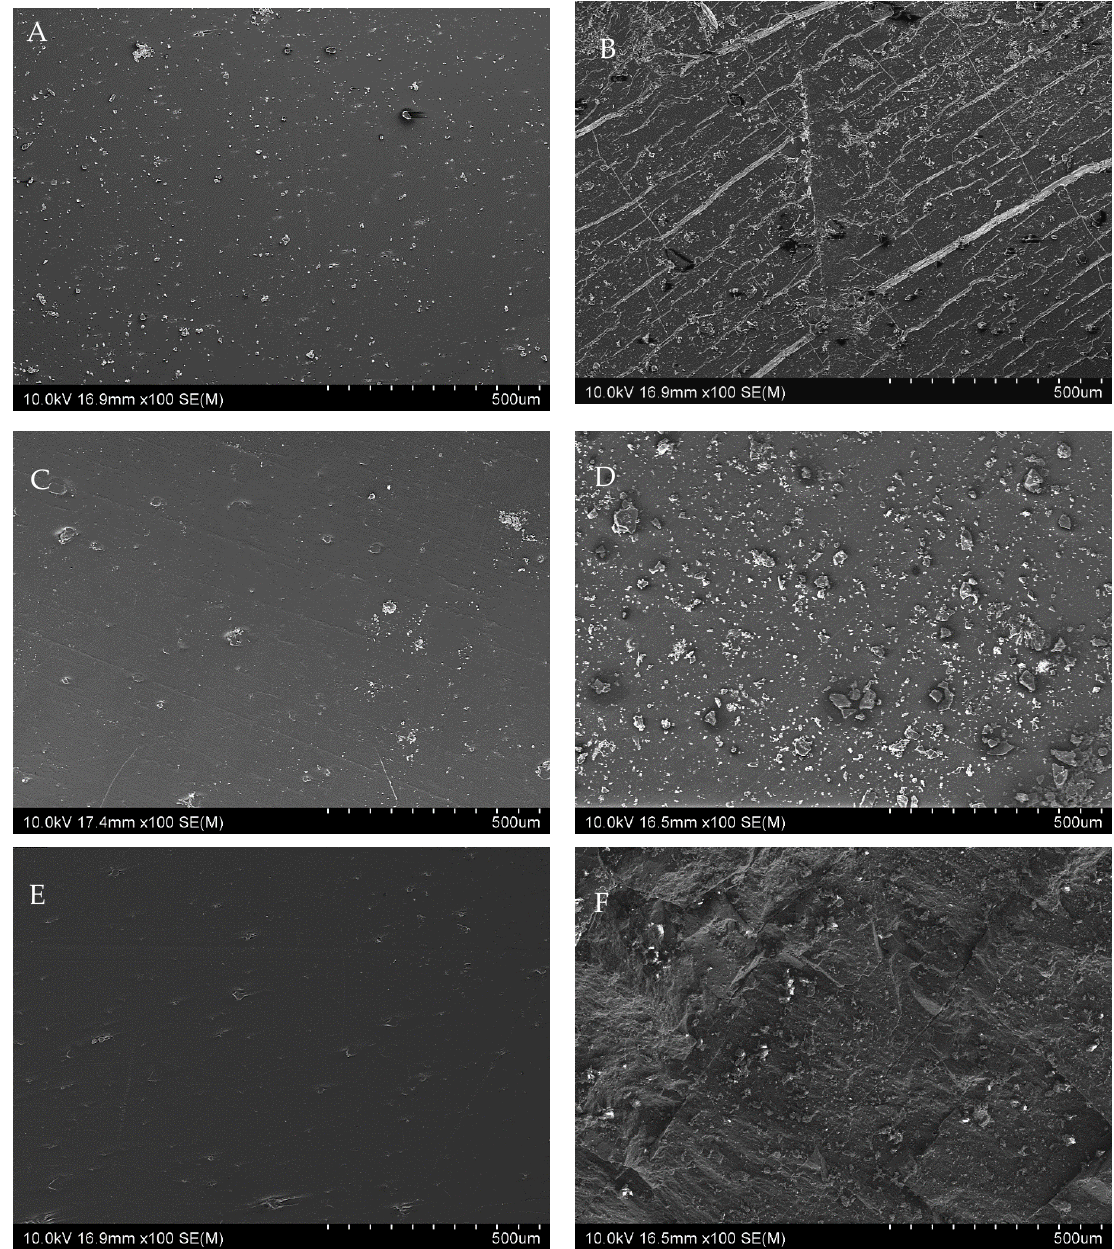
Figure 4. SEM images of: ( A ) — unaged iPP/CC; ( B ) — iPP/CC after UV exposure for 1000 h;